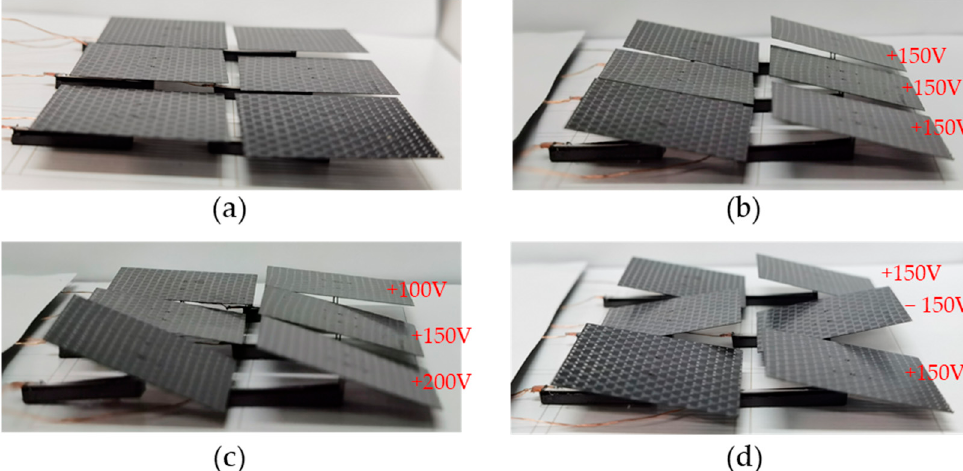
Figure 12. Tests of deformable skin: ( a ) no signal input; ( b ) drive signals given to the three groups all forward biased at 150 V; ( c ) drive signals given to the three groups are 100 V forward biased, 150 V forward biased, and 200 V forward biased; ( d ) drive signals given to the three groups are 150 V forward biased, 150 V reverse biased, and 150 V forward biased.